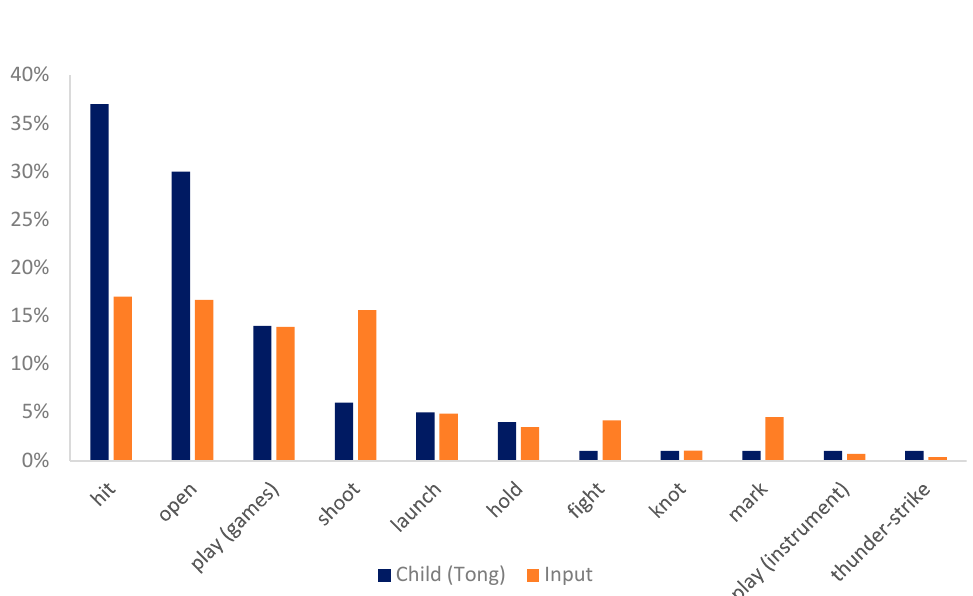
Figure 5. Proportions of different senses of 打 d ǎ in Tong and his input.